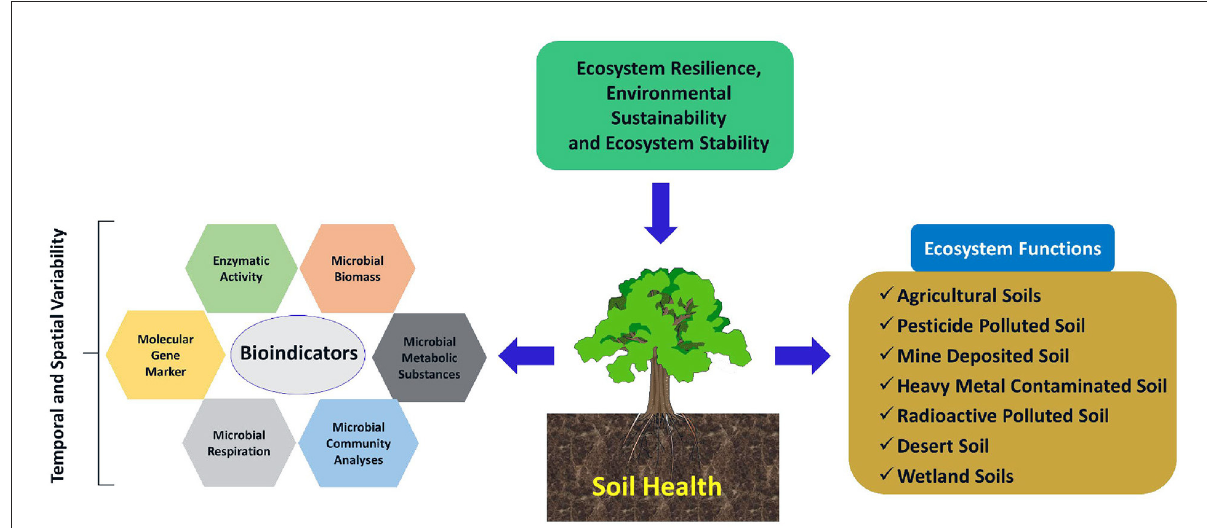
FIGURE2 Schematic representation of soil health as an indicator of ecosystem resilience and stability. Soil health can be quantified and qualified in terms of various bio-indicators (e.g., Microbial biomass, respiration, metabolic substances, and community analyses as well as some enzymatic activity and molecular techniques) both at temporal and spatial scales. Multiple soil management system can strategize as a critical factor to determine the response mechanism of different